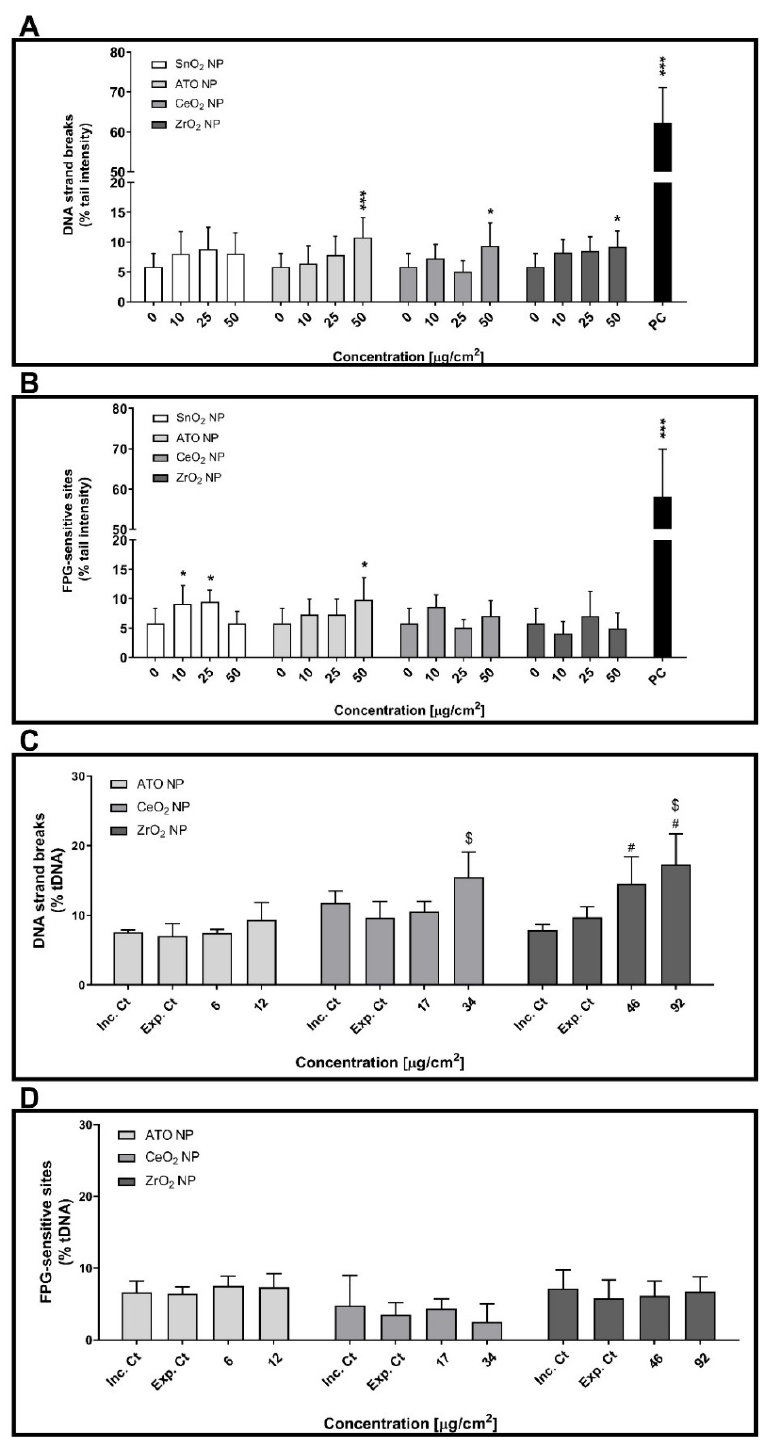
Figure 6. Genotoxicity of the tested engineered nanoparticles (ENP) in human alveolar epithelial cells under submerged ( A , B ) and ALI ( C , D ) conditions. Primary ( A , C ) and oxidative ( B , D ) DNA damage were assessed at 24 h after exposure to the ENP suspensions by the alkaline and FPG-modified comet assay versions, respectively. Data are expressed as mean ± standard deviation ( n = 3–4). Data was analysed by one-way ANOVA followed by Dunnett’s post-hoc test. * p ≤ 0.05 and *** p ≤ 0.001 vs. negative control. # p ≤ 0.05 vs. incubator control and $ p ≤ 0.05 vs. exposure control. PC: Positive control; 500 µ M MMS and 2.5 mM KBrO 3 for primary ( A ) and oxidative ( B ) DNA damage under submerged conditions, respectively.